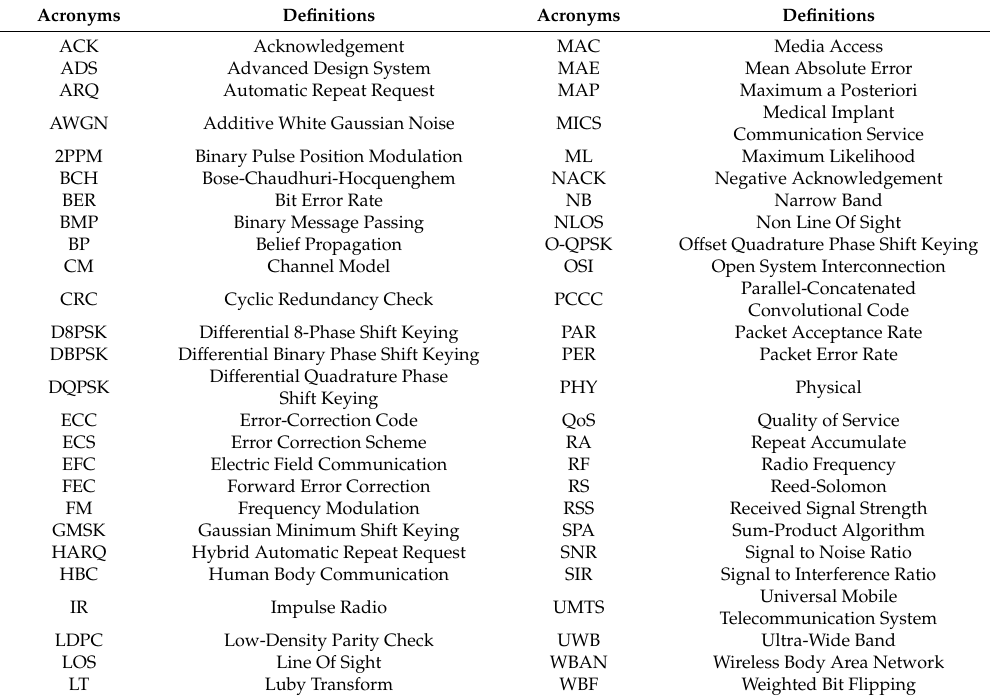
Table A1. A list of